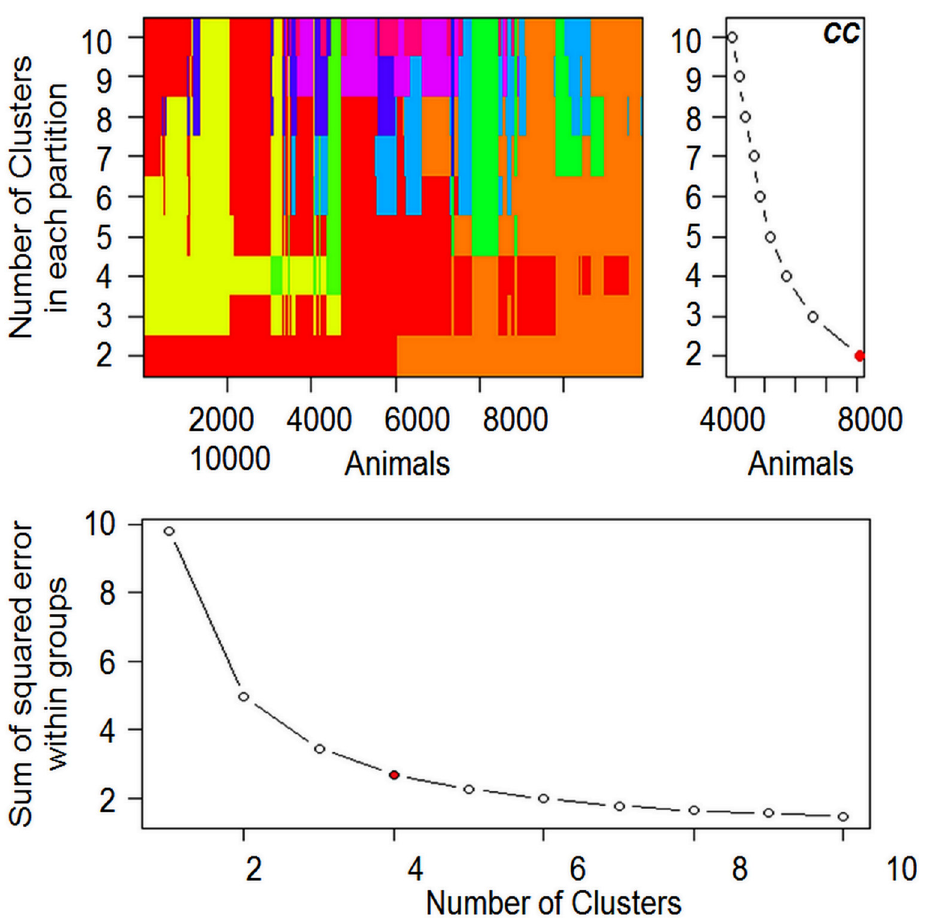
Fig 1. Plots of different approaches (visual k-mean partition comparison, Calinsky criterion ( CC ), and sum of squared error within groups) used in order to detect the optimal number of clusters. Using the k-mean comparison, the number of colors is in accordance with the number of clusters in each